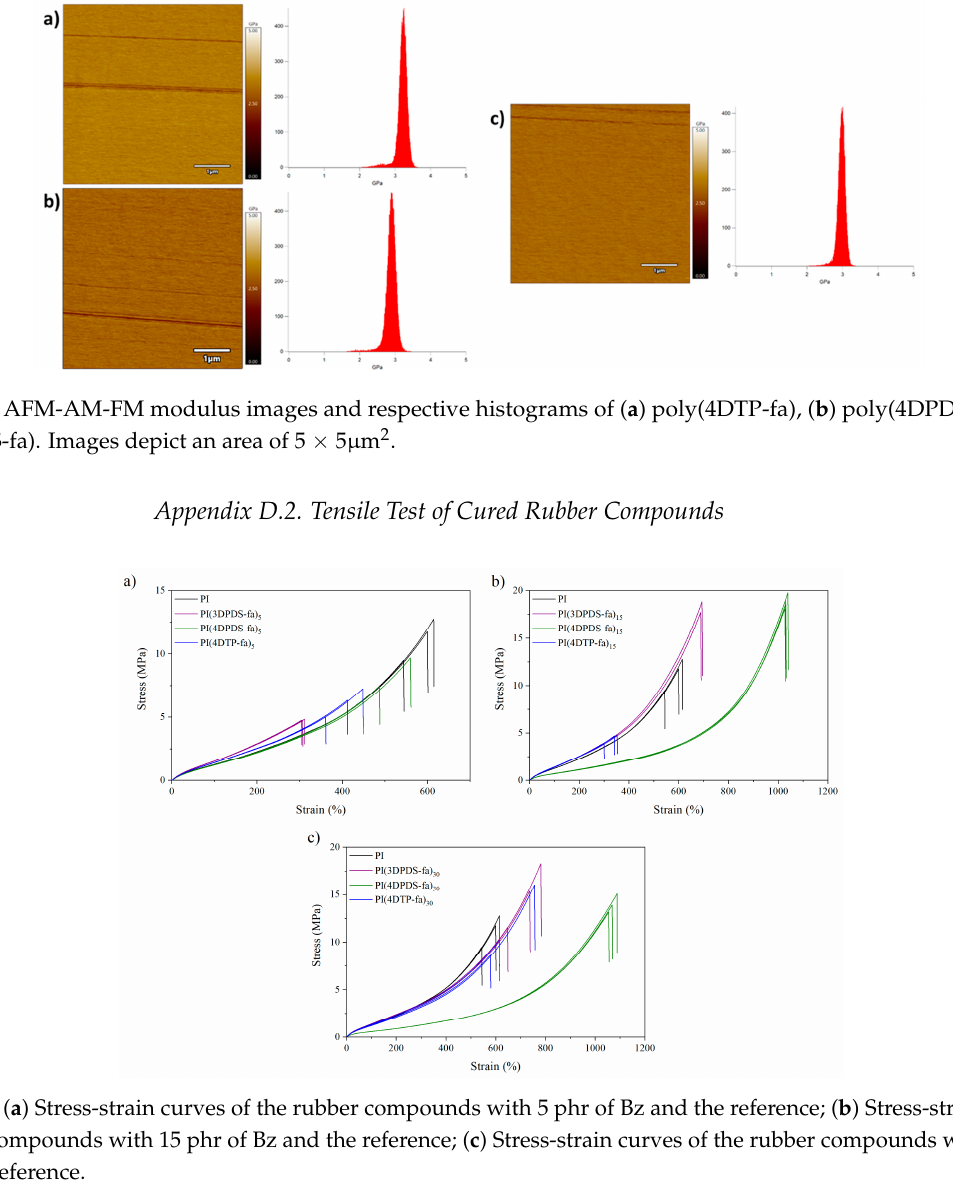
Figure A30. AFM-AM-FM loss tangent images and measurements of the property in each of the phases in the material. Images depict an area of 20 × 20 μ m 2 .